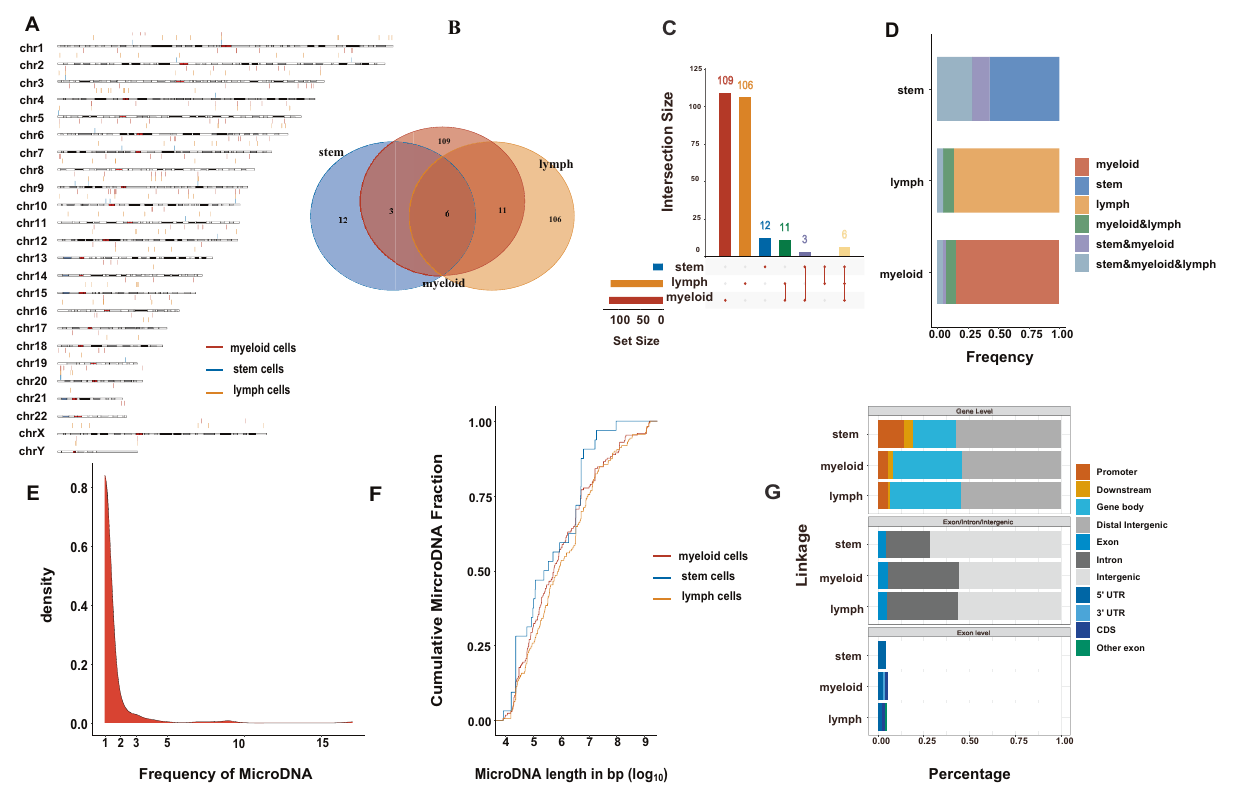
Fig. 2 MicroDNA in the normal stem, myeloid, and lymphoid cells. A Chromosome ideogram plot showed the distribution of microDNA of stem, myeloid, and lymphoid cells. B Venn diagram of overlapping microDNA. C The barplot identi fi ed the microDNA number in the overlap of different cells. X-axis represents the cell type; Y-axis represents the average number of microDNA. D The frequency of overlapping microDNA in stem, myeloid, and lymphoid cells, respectively. E Frequency distribution graph showed that more than 80% microDNA only appeared once. F Length distribution of identi fi ed microDNA in stem, myeloid, and lymphoid cells. G microDNA distribution over different genomic features. At gene level, ~50% microDNA were mainly enriched in the promoter, downstream, and gene body. At exon/intron/ intergenic level, most microDNA were enriched in intron and intergenic regions. At exon level, microDNA were mainly enriched in 5 ′